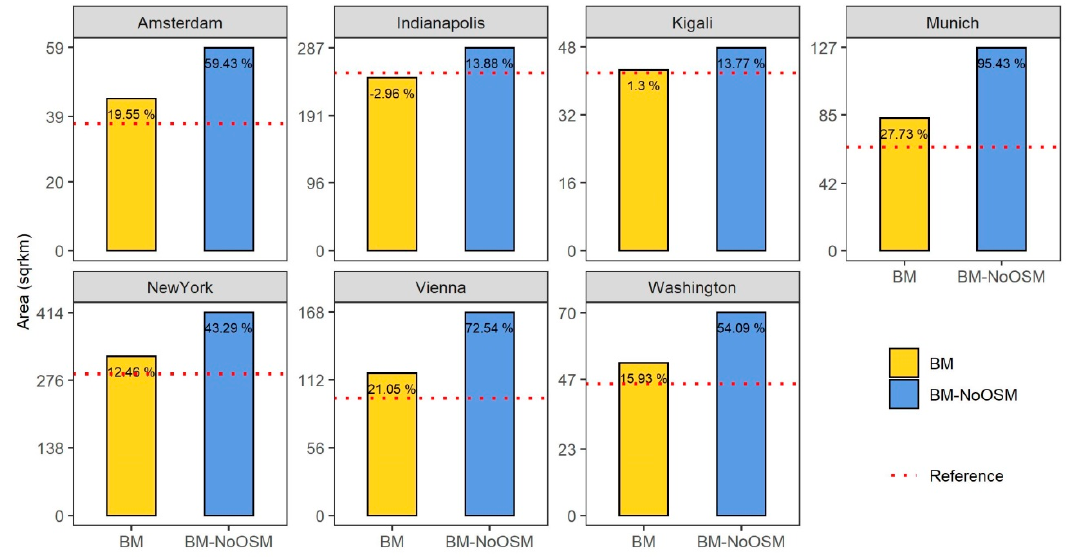
Figure 4. Percentage error per city between the estimated and actual total building area.